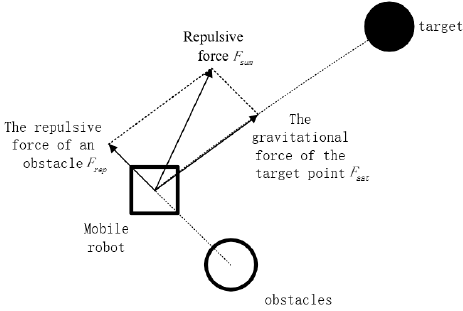
Figure 4. Force analysis of robot in artificial potential field.